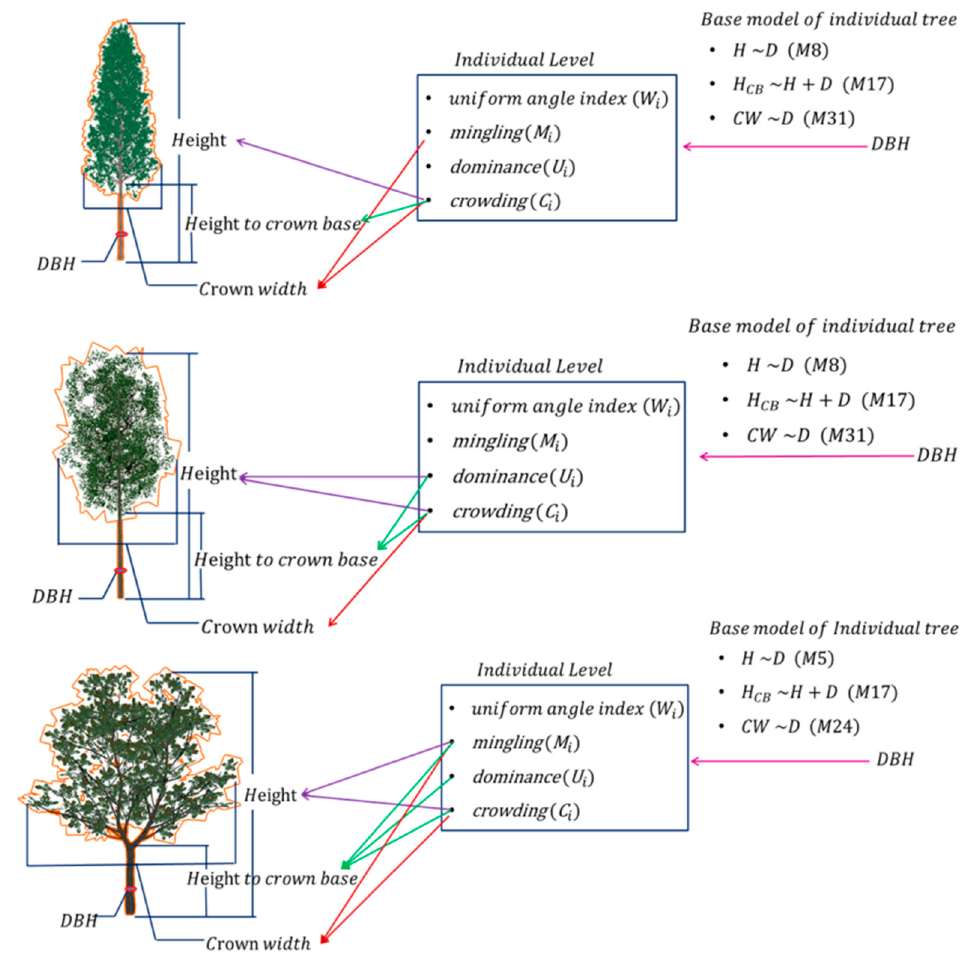
Figure 6. Three-dimensional tree modeling of three predominant trees based on a structural unit.